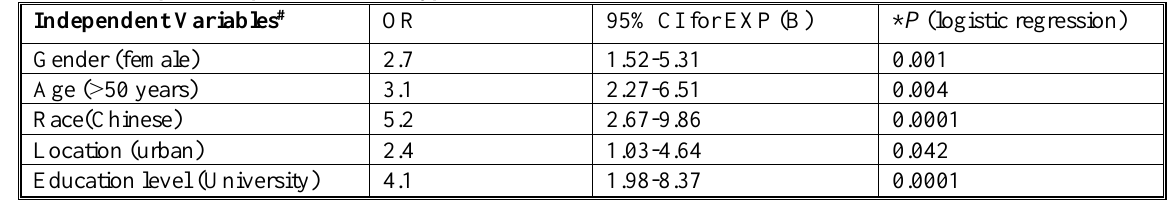
Table 4. Independent predictors for hypertension